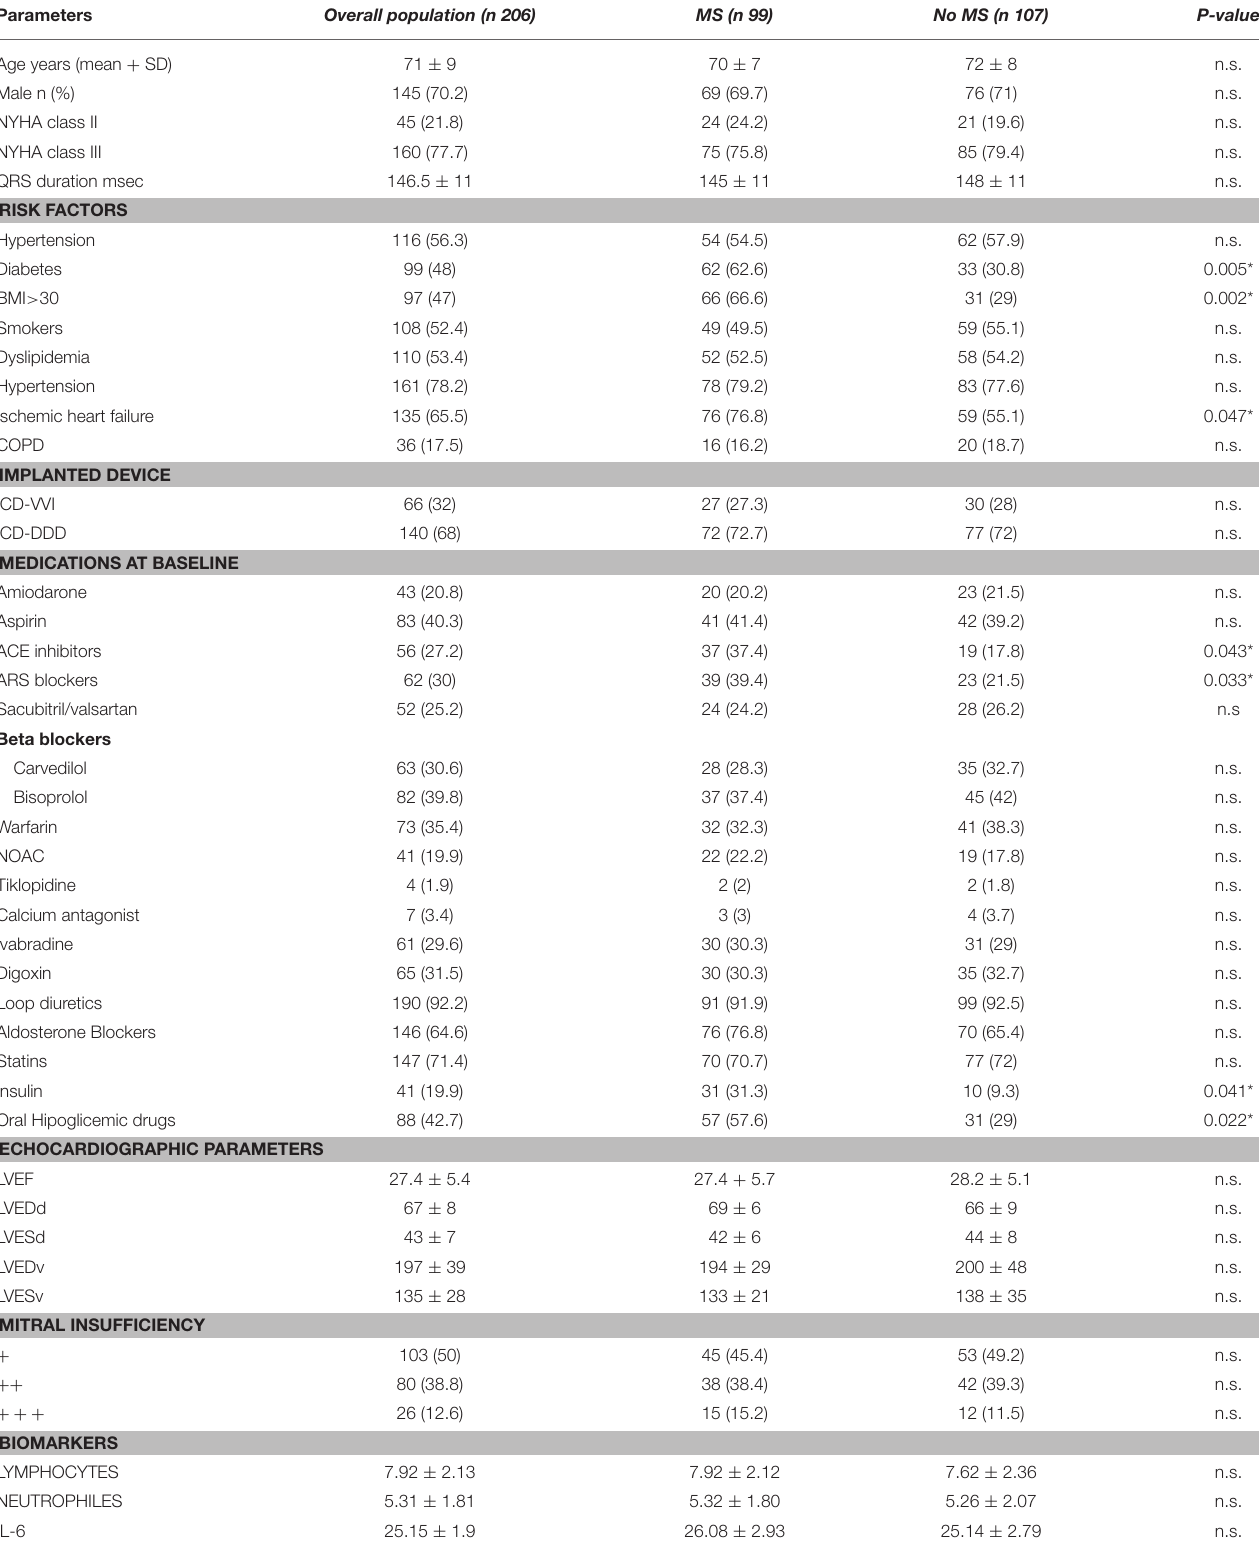
TABLE 1 | Baseline characteristics of study